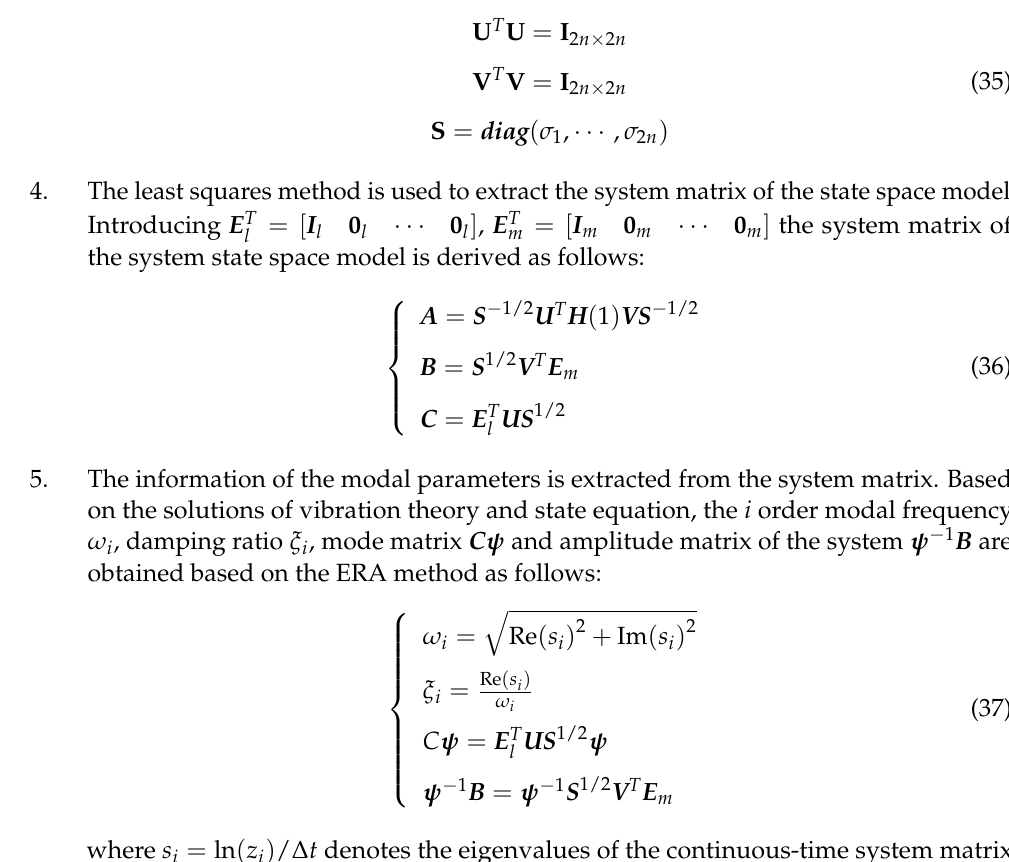
The least squares method is used to extract the system matrix of the state space model. = [ I Introducing E T l l